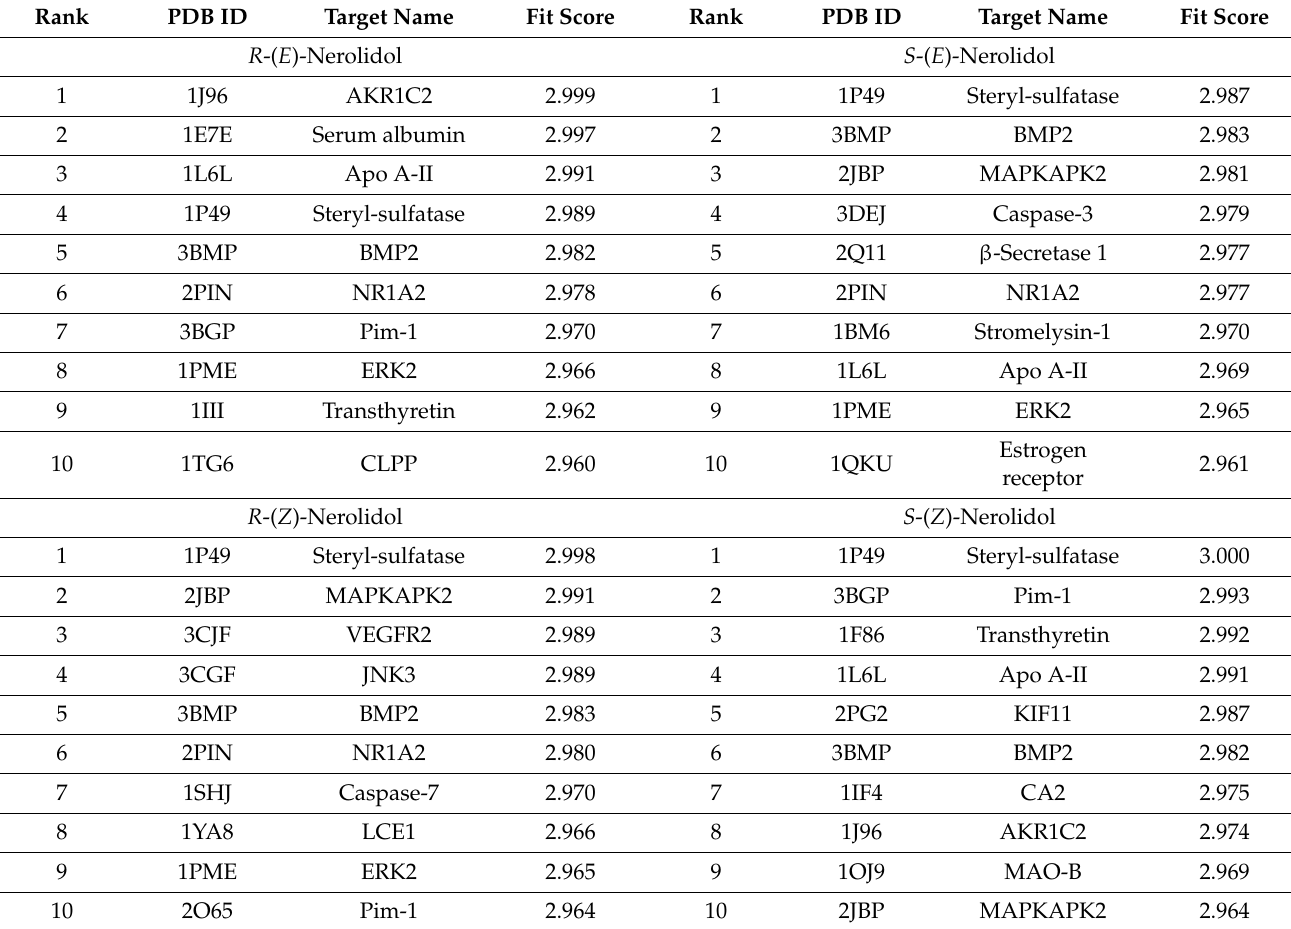
Table 4. Potential protein targets for nerolidol isomers identified by